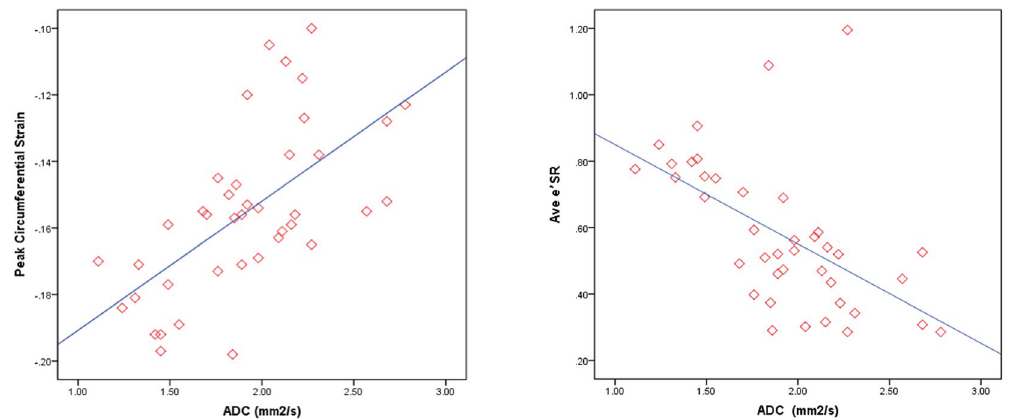
Figure 5. ( a ) Peak circumferential strain versus ADC. Pearson’s correlation shows a linear association between ADC and peak circumferential strain (R = 0.392, p < 0.05). ( b ) Mean early diastolic circumferential strain rate versus ADC. Pearson’s correlation shows a linear association between ADC and peak circumferential strain rate (R = − 0.305, p <